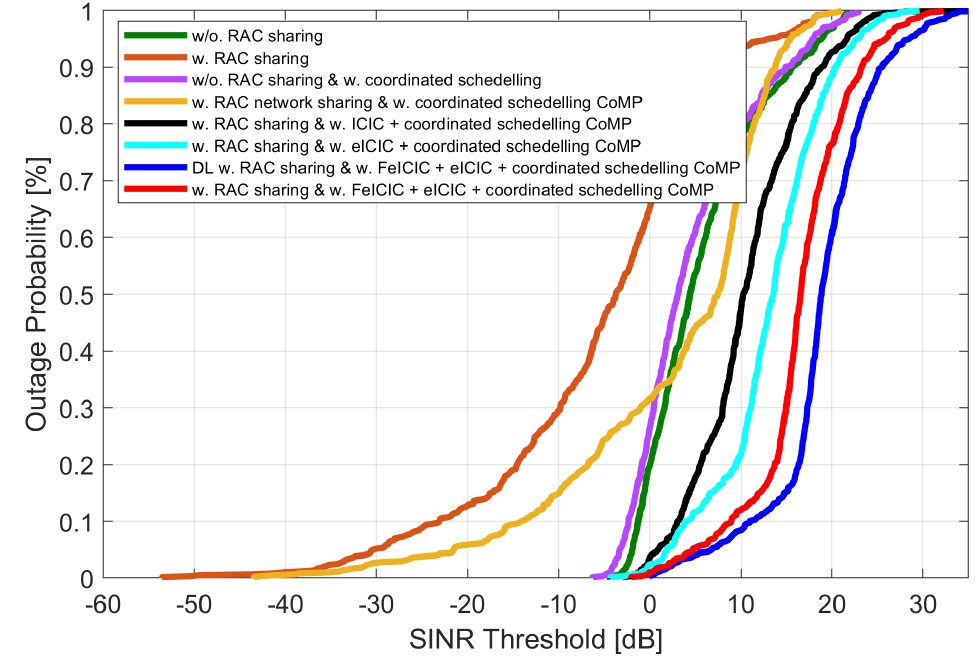
Figure 4. Outage probability vs. SINR